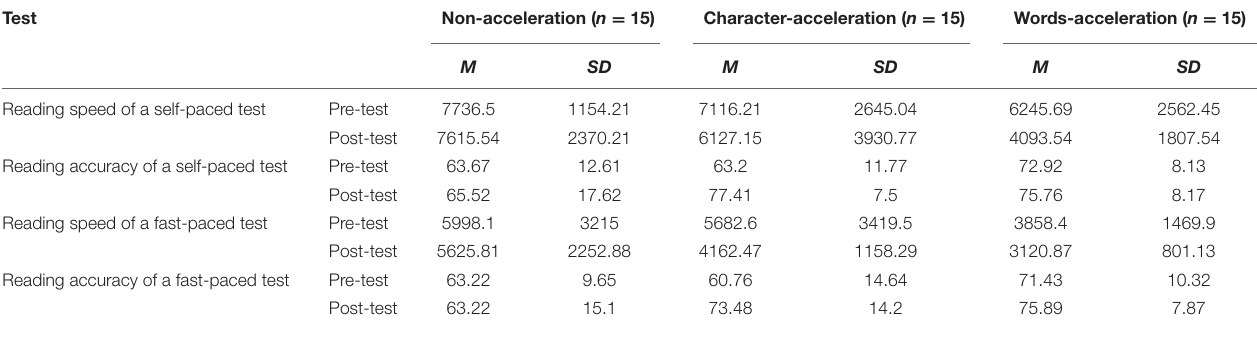
TABLE 2 | The reading speed and comprehension accuracy of pre-test and post-test in different accelerated reading training group.